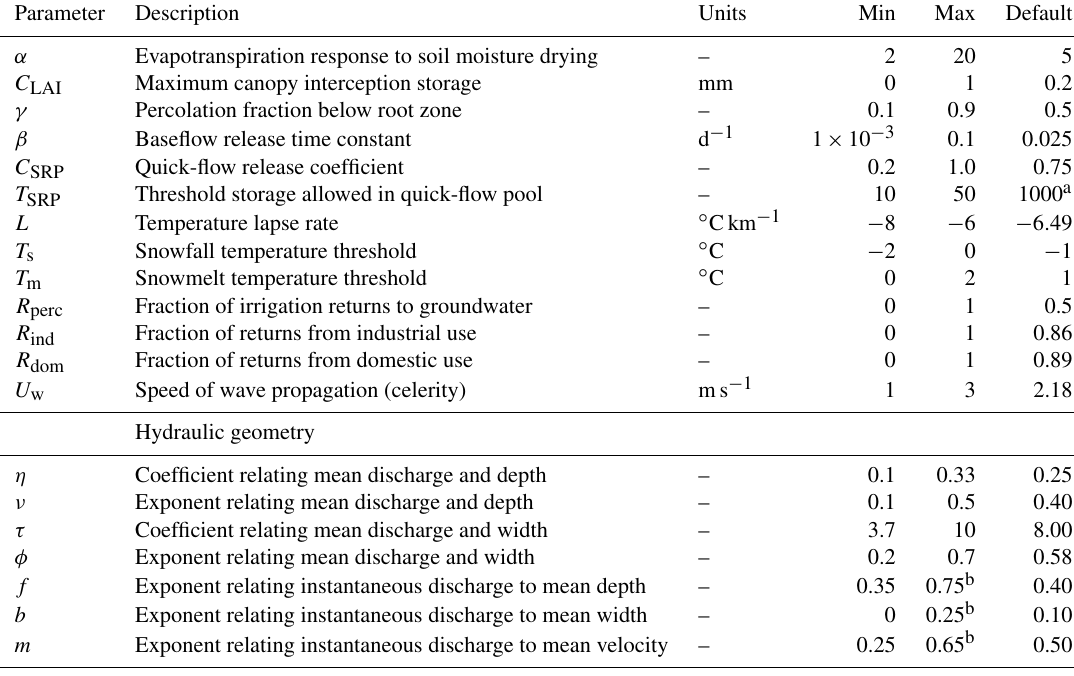
Table 1. Default parameter values with suggested minimum (Min) and maximum (Max) parameter ranges, and the WBM default value (Default) when the parameter value is not